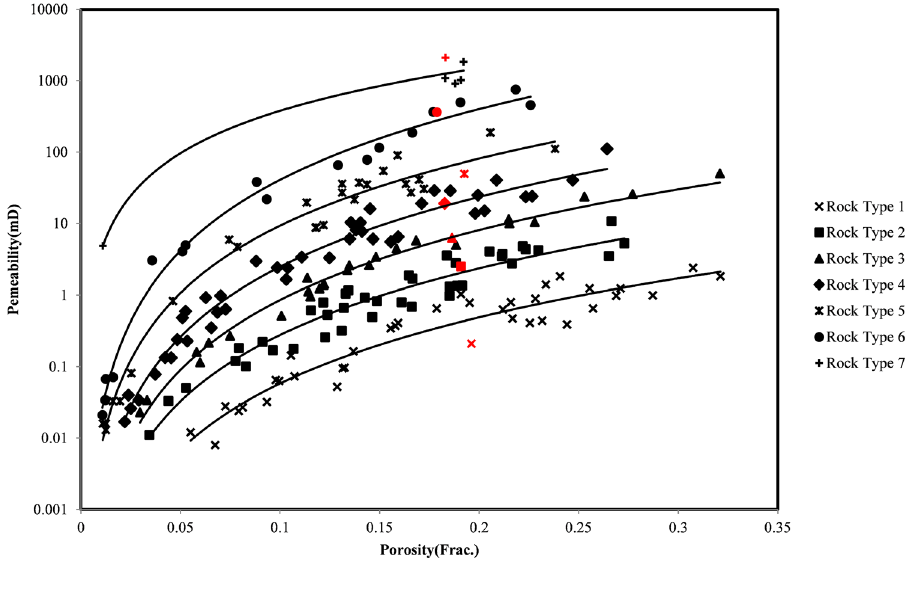
Fig. 5 Representative